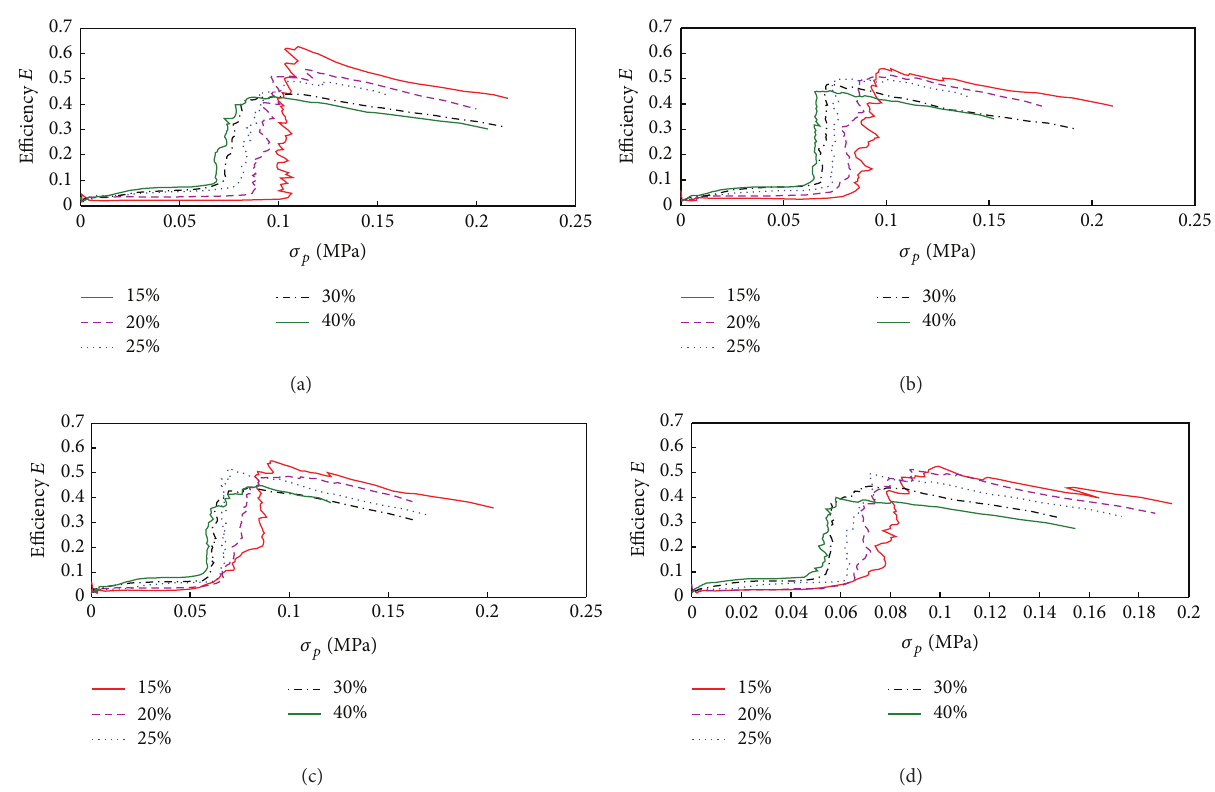
Figure 5: Energy absorption efficiency curves of various precompressed honeycomb paperboard in different FD ( 𝑡/𝑙 = 0.0263 ) (a) 𝑛 = 10000 , (b) 𝑛 = 20000 , (c) 𝑛 = 30000 , and (d) 𝑛 = 50000 .